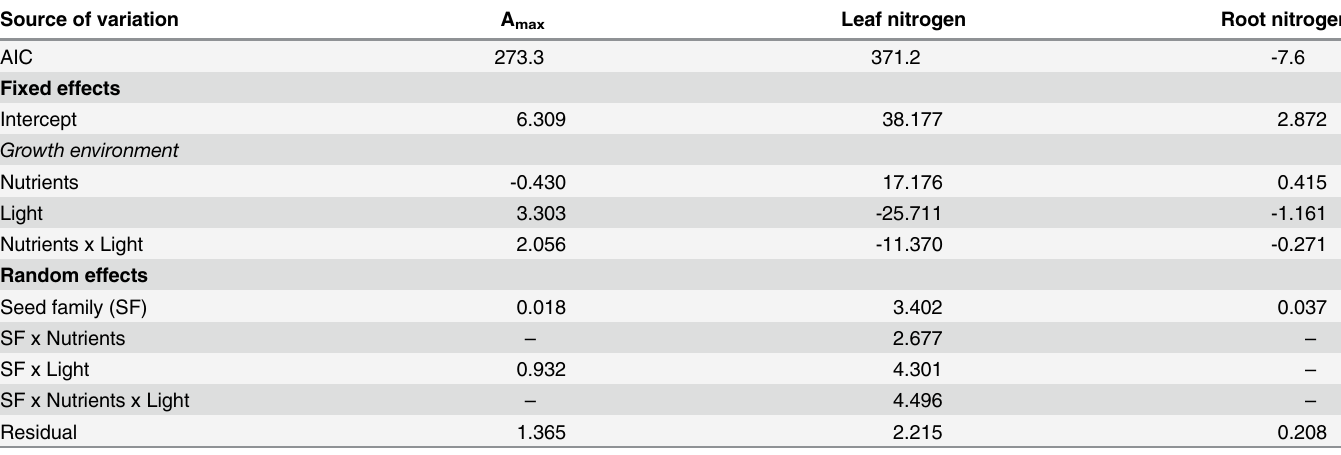
Table 3. Summary of mixed-effects model analyses of maximum rates of photosynthesis (A max ) and nitrogen concentrations in leaves and roots of Plantago lanceolata . Plants were grown at two different levels of nutrient and light availability and originated from three seed families taken from the monoculture and a 60-species